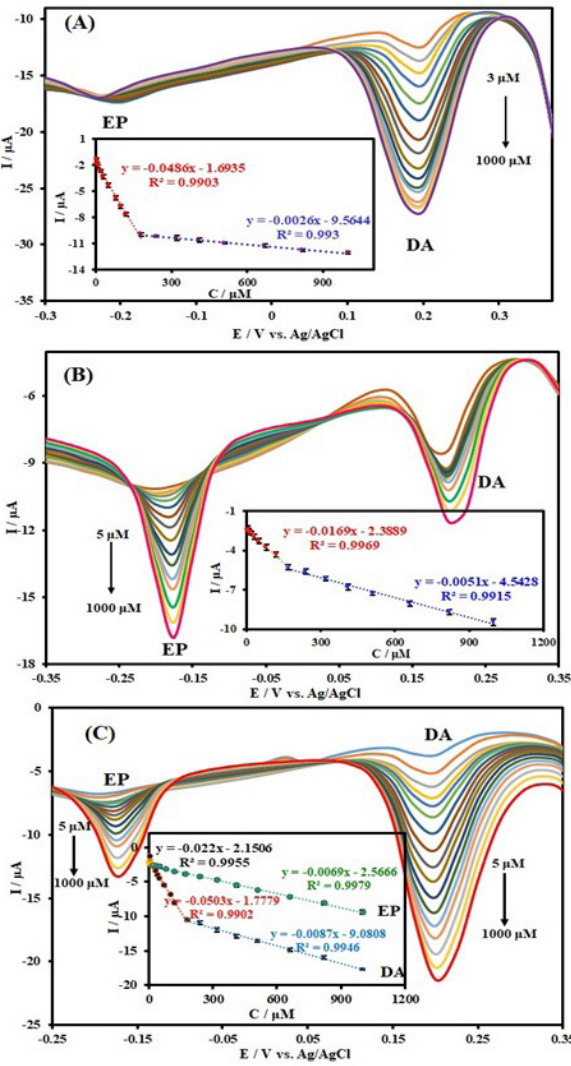
Fig. 11. DPVs of (A) different concentrations of DA (3-1000 µM) in the presence of 15 µM EP; (B) different concentrations of EP (5- 1000 µM) in the presence of 15 µM DA, (C) DPV curves for mixtures of DA and EP with different concentrations as follows: (a) 5.0 + 5.0, (b) 7.5 + 7.5, (c) 10 + 10, (c) 15 + 15, (d) 20 + 20, (e) 30 + 30, (f) 50 + 50, (g) 80 + 80, (h) 120 + 120, (i) 180 + 180, (j) 240 + 240, (k) 320 + 320, (l) 410 + 410, (m) 510 + 510, (n) 660 + 660, (o) 820 + 820, and (p) 1000 + 1000 respectively, where the first value is the concentration of DA in µM, and the second value is the concentration of EP in µM, at GCE/RGO/TiO surface in 0.04 M BRS solution 2 at pH 7.0, and (Inset: Plots of peak current as a function of the species